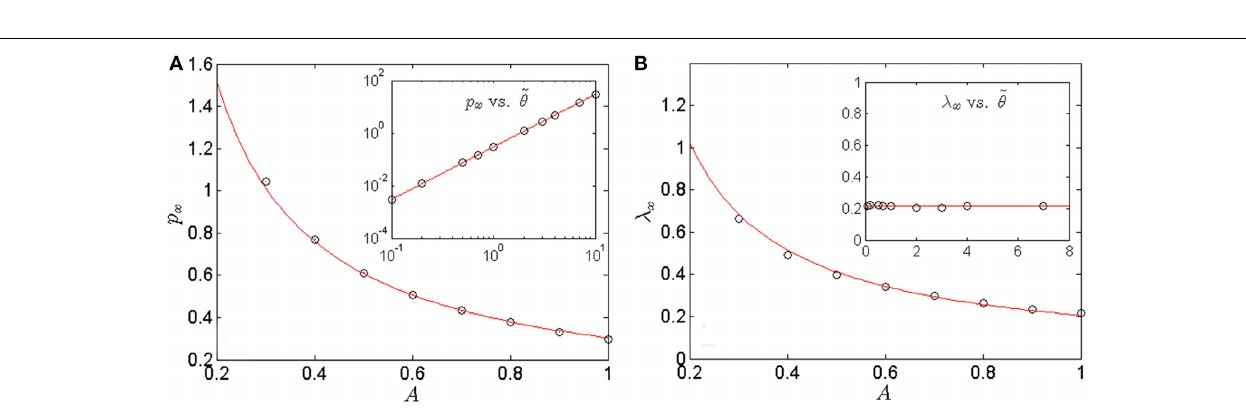
confident interval). (B) Characteristic length-scale λ x associated with the curve S x vs .(cid:17) x as a function of A at constant ˜ θ = 1 (main) and ˜ θ at constant A = 1 (inset). In both graphs, the red lines are fits λ x = 0 . 21 ± 0 . 02 / A (main) and λ x = 0 . 21 ± 0 . 02 (inset). Here, ± indicates a 95% confident